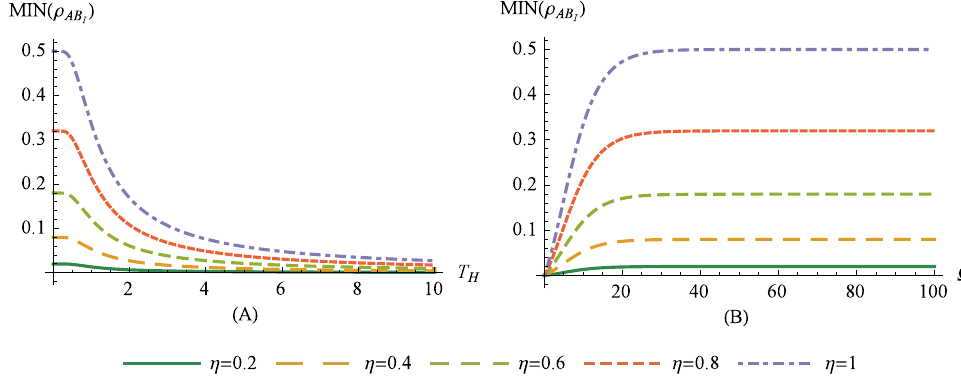
Figure 2. The measurement-induced nonlocality (MIN) as a function of ( A ) the Hawking temperature ( T H ) and ( B ) the bosonic frequency ( Ω ) for the physically accessible correlations in the case of the bosonic modes ( ρ AB ). The results are presented for the selected values of the entanglement parameter I ( η ), assuming ( A ) the fixed fermionic frequency ( Ω = 1) or ( B ) the fixed Hawking temperature ( T H =